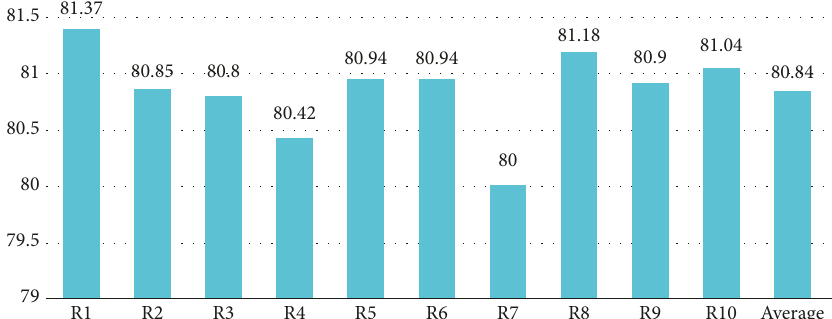
Figure 5: Results of 10 runs of the proposed method in the classification accuracy criterion with an average of 10